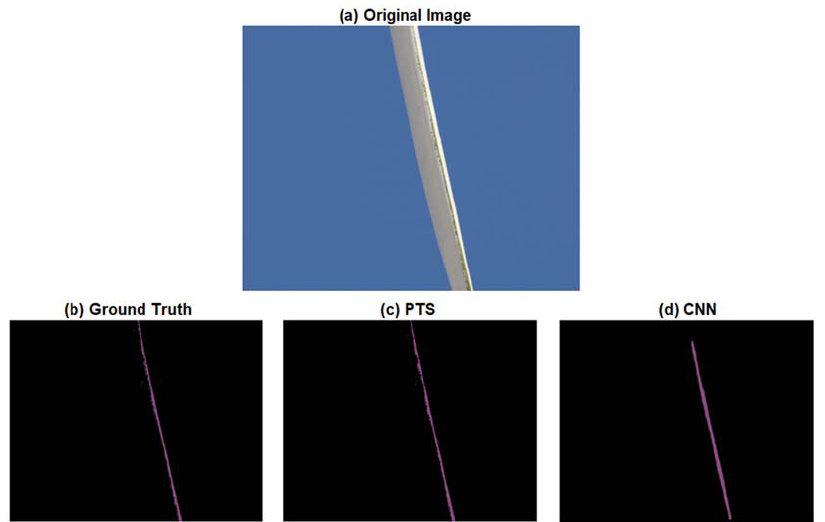
Figure 8. Example ( a ) field image and output of automated ( c ) PTS and ( d ) CNN LEE quantification and classification for shallow (green) and deep (magenta) LEE compared to ( b ) ground-truth LEE quanti fi cation and classi fi cation.